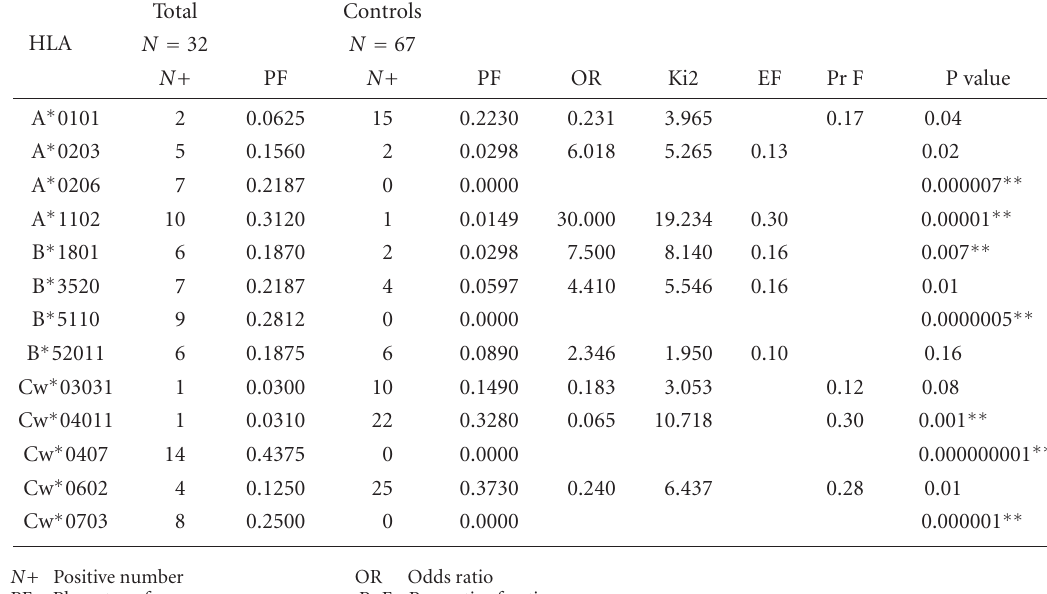
Table 1. High risk HLA class I allele subtypes among the leprosy patients, Mumbai, India.